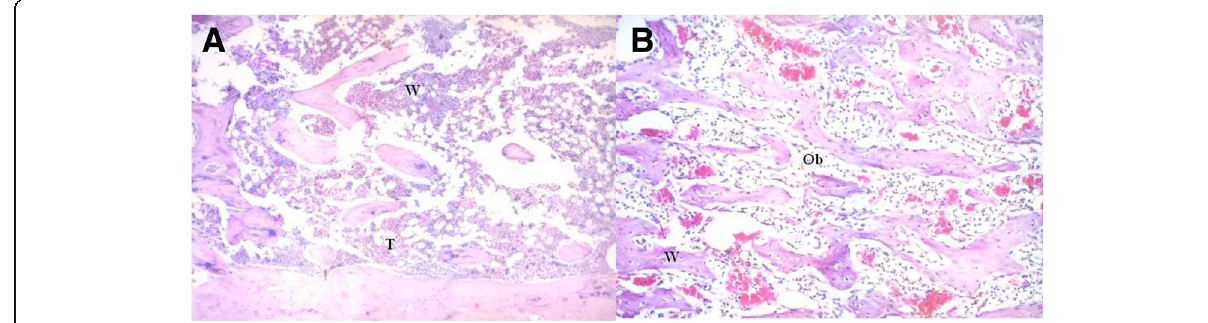
Fig. 2 Hematoxylin- and eosin-stained histological sections of Calcitonin group. a After a week, the healing process was faster than expected. Trabecular bone and bone marrow development (grade 5) were noted instead of massive osteoblasts and new bone formation (grade 3) (X40).